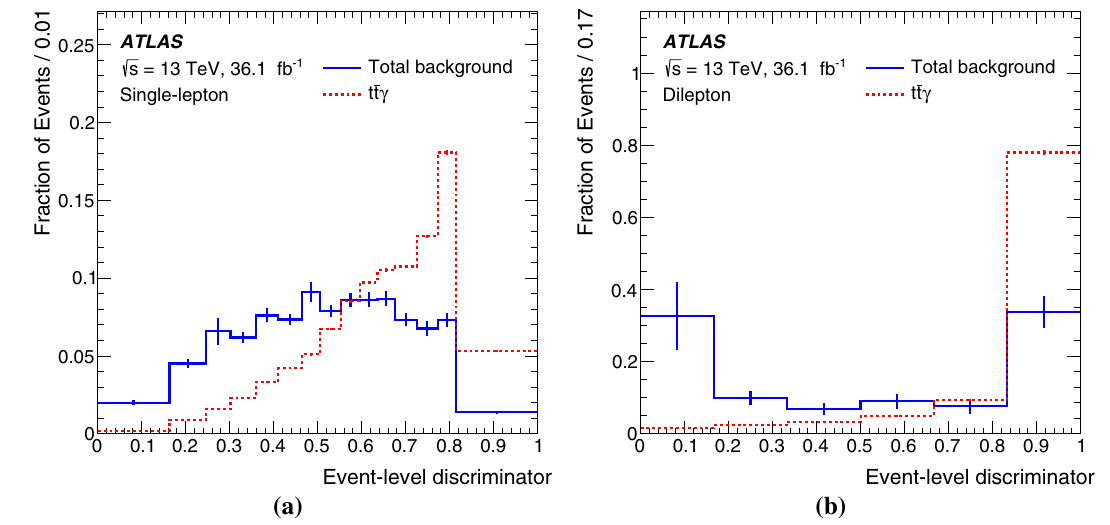
Fig. 5 ComparisonoftheshapeoftheELDbetweensignalandtotalbackground inthe a single-leptonand b dileptonchannelsaftereventselection. All data-driven corrections are included